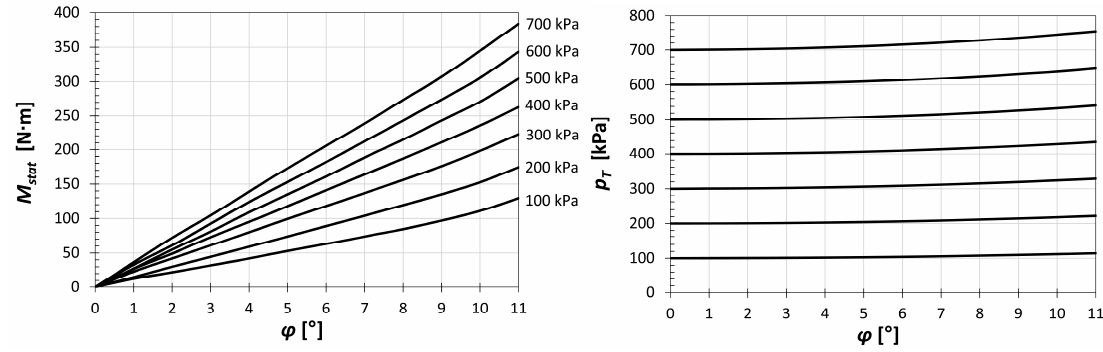
Figure 2. Results of 4–2 / 70–T–C -type pneumatic tuner of torsional oscillations static measurements: ( a ) static load characteristics; ( b ) overpressure.